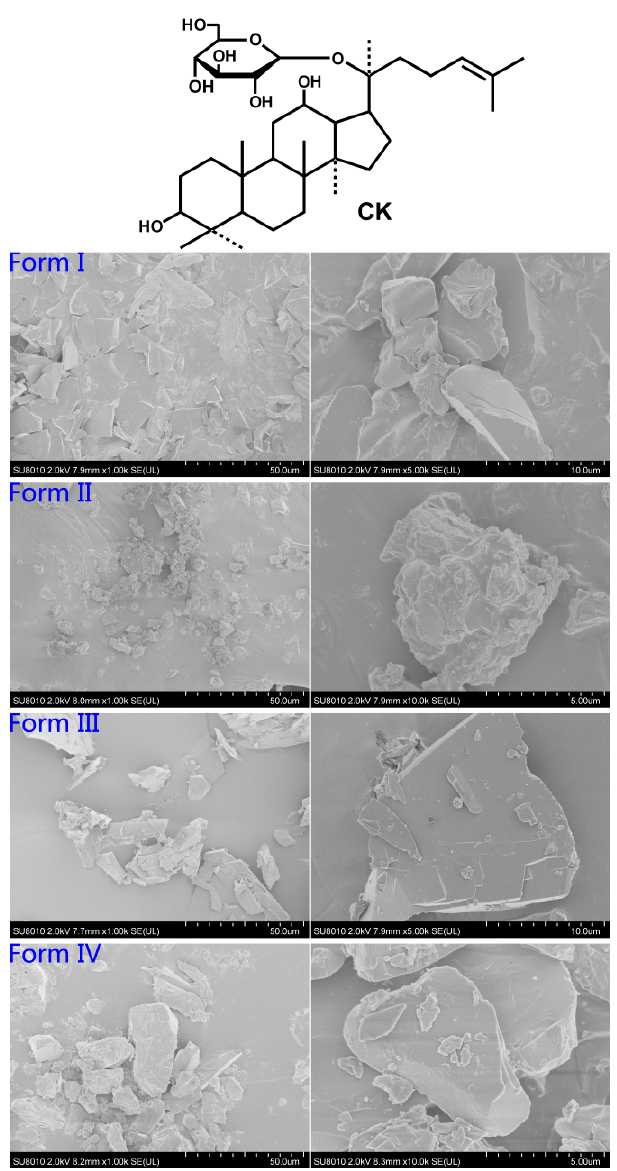
Figure 1. Chemical structure of compound K (CK) and scanning electron microphotographs of the four forms at 2.0 kV. Form I (magnification from left to right: 1000×, 5000×); form II (magnification from left to right: 1000×, 10,000×); form III (magnification from left to right: 1000×, 5000×); and form IV (magnification from left to right: 1000×, 10,000×).